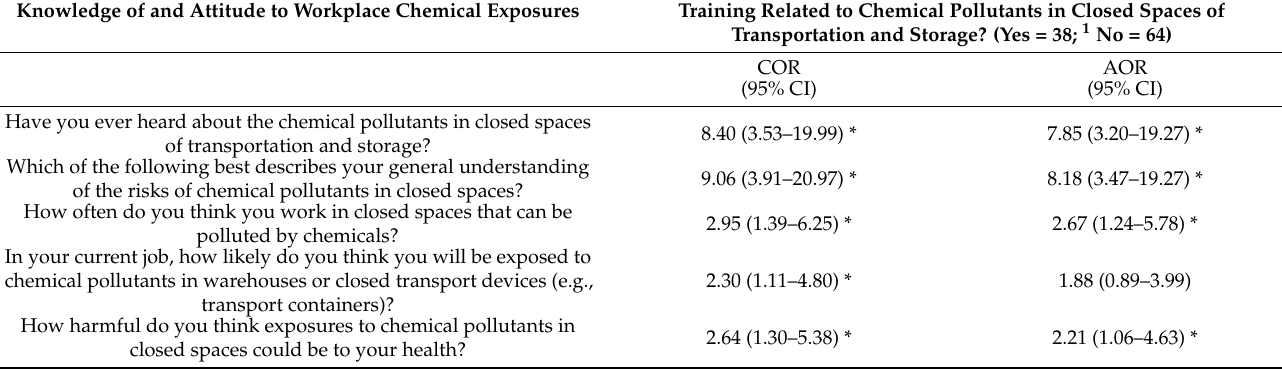
Table 6. Association between completing specific workplace health and safety training related to chemical pollutants and the knowledge of and attitude to workplace chemical exposures in closed spaces of transportation and storage. Knowledge of and Attitude to Workplace Chemical